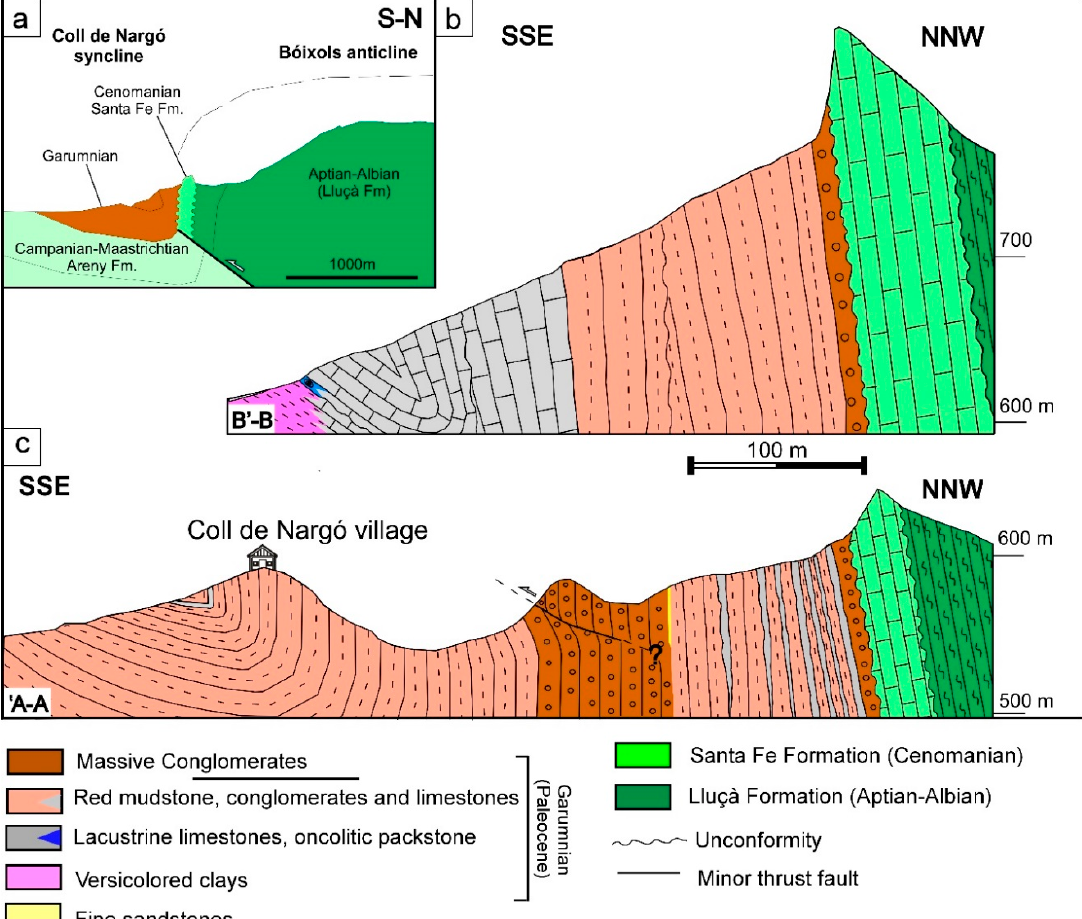
Figure 4. ( a ) Cross-section of the Coll de Nargó syncline and the Bóixols anticline. The northern limb of the Coll de Nargó synclinebelongs to the southern limb of theBóixols anticline. ( b , c ) schematic cross sections in the frontal part of the Bóixols thrust sheet in the study area. Location in Figure 3.